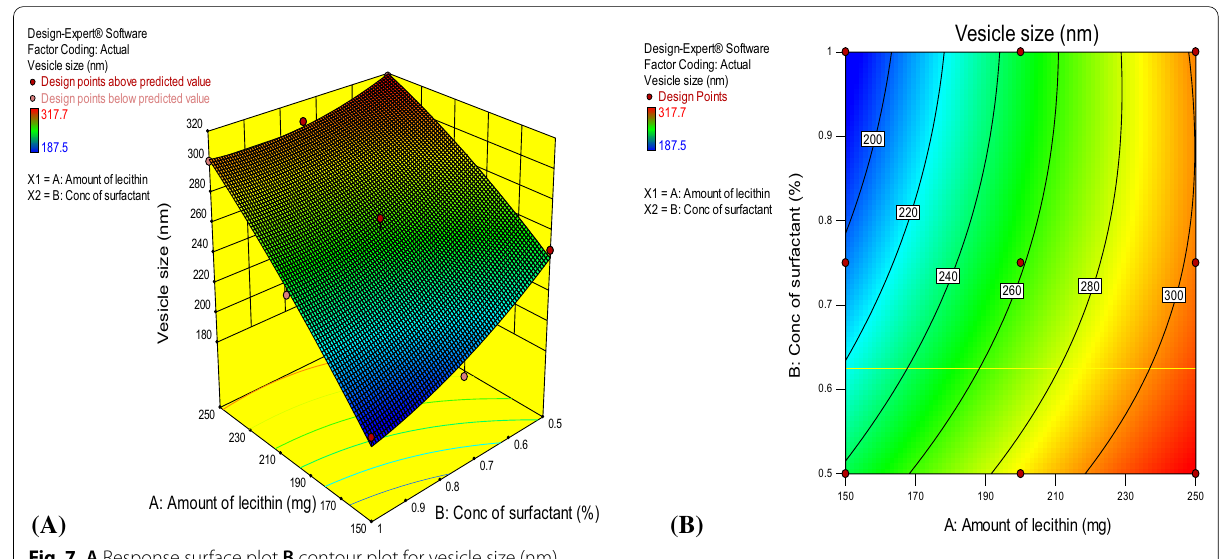
Fig. 7 A Response surface plot B contour plot for vesicle size